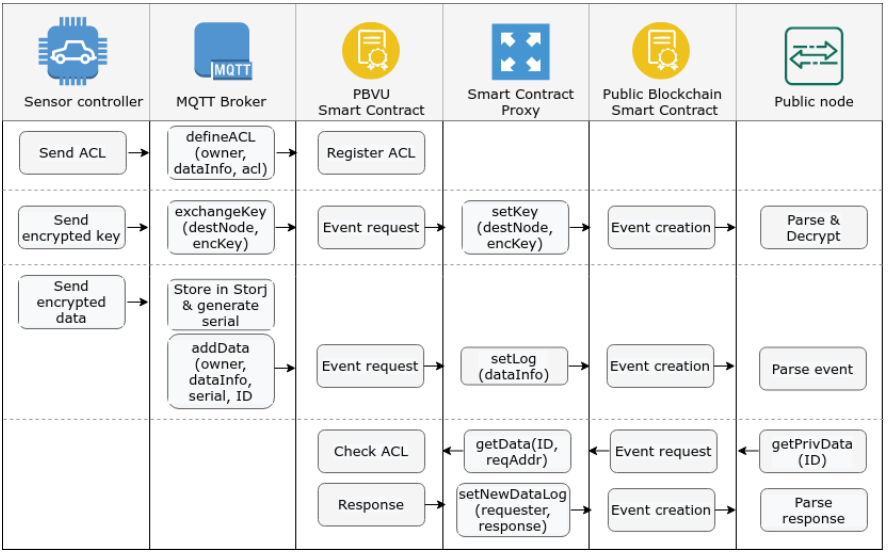
Figure 2. Overview of the system’s